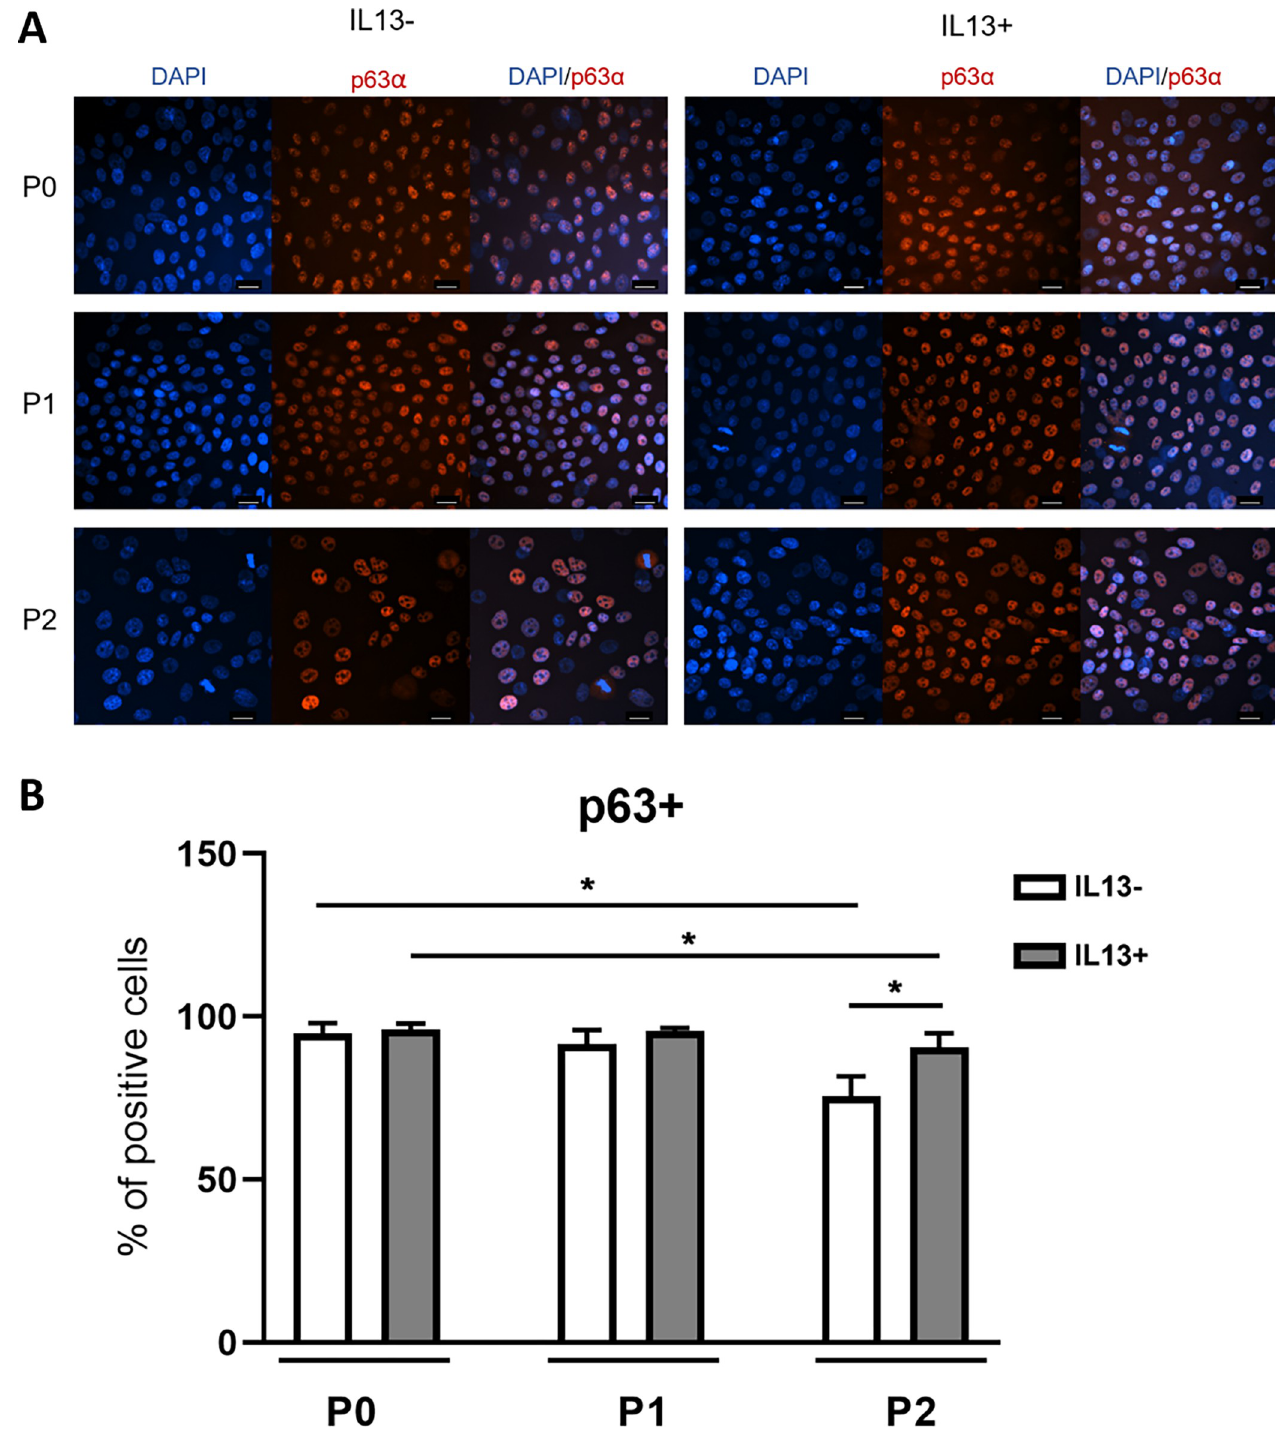
Fig 4. Immunostaining for the putative limbal stem cell marker p63 α in IL13- and IL13+ cell cultures. (A) Cells were analyzed by immunofluorescent staining for p63 α (red) at the end of P0-P2 cultures. Nuclei were counterstained with DAPI (blue). Scale bars: 20 μ m. (B) Distribution of percentages in the P0, P1, and P2 groups for p63 α staining. Each bar represents the mean ± SD of three to eight determinations. The asterisks represent a statistically significant difference between the examined groups ( � P � 0.05).